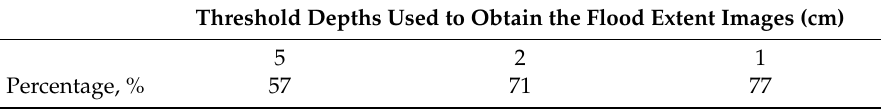
Table 1. Overlapping ratios of the flood extents of Modis image and the proposed